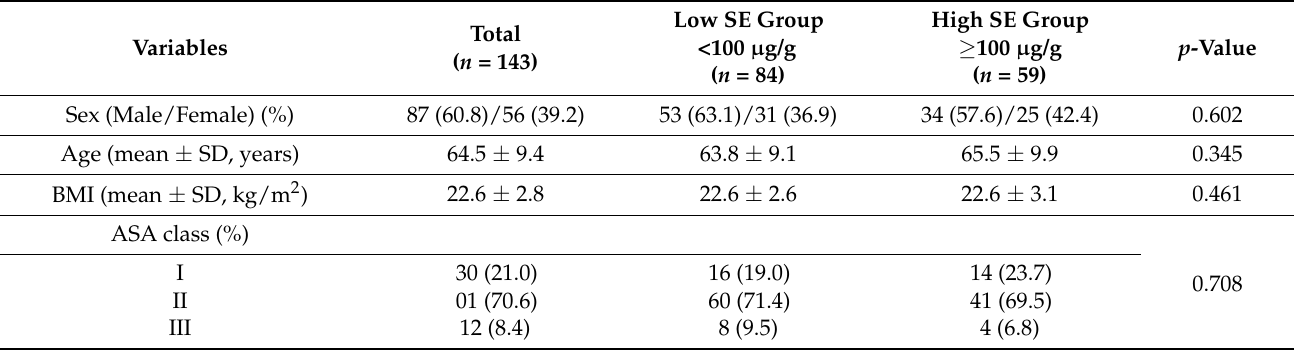
Table 1. Clinicopathological features according to preoperative stool elastase